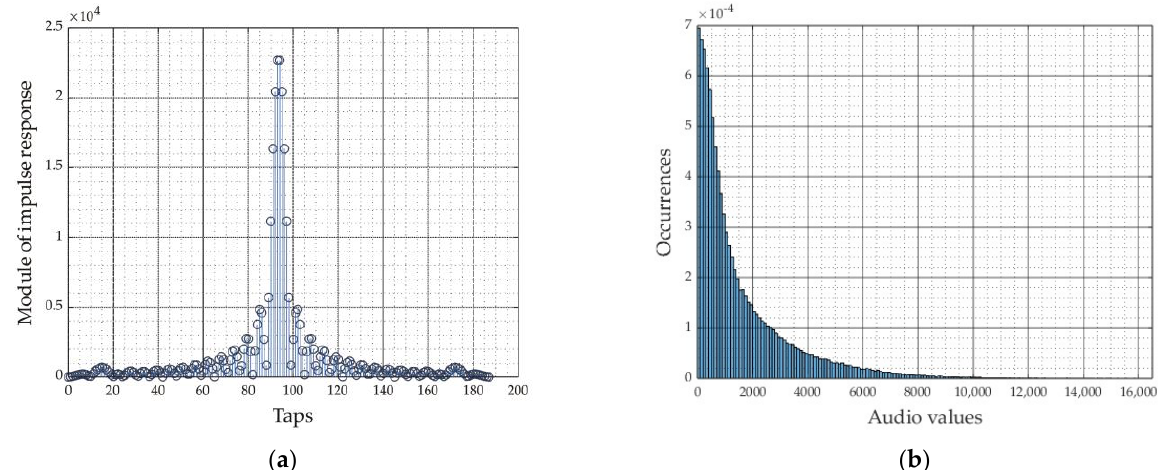
Figure 9. ( a ) Module of the impulse response of the low-pass FIR filter and ( b ) histogram of occur- rences of the audio signal.